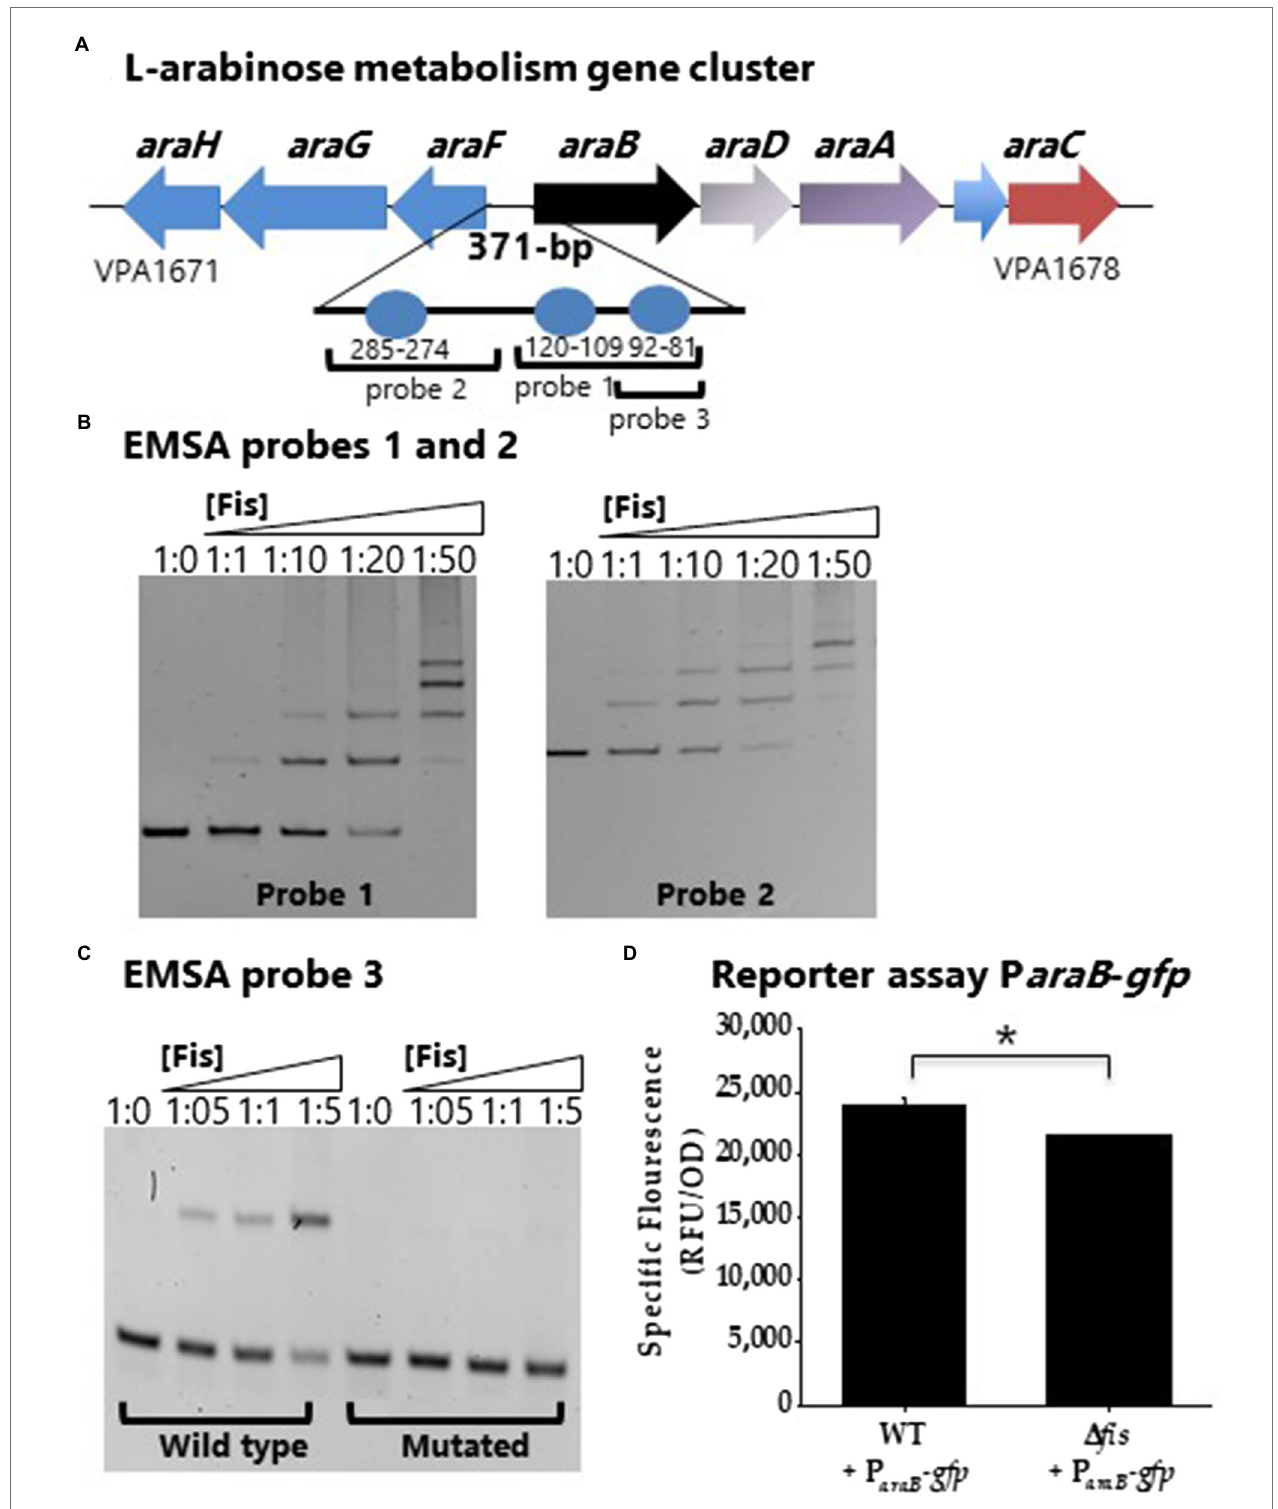
FIGURE 8 | Fis is a positive regulator of the L-arabinose operon araBCDA . (A) Fis binding sites identified in the regulatory region of the araBDAC operon depicted as blue circles. (B) P araB was divided into two probes, probe 1 and probe 2 for EMSA analysis using purified Fis protein. (C) EMSA analysis probe 3 wild type with a single Fis BS and a mutated probe 3. DNA: protein ratios were as follows: 10, 1:1, 1:10, 1:20, 1:50. (D) GFP transcriptional reporter assay of the araBDAC regulatory region in wild type and the Δ fis mutant. * p <